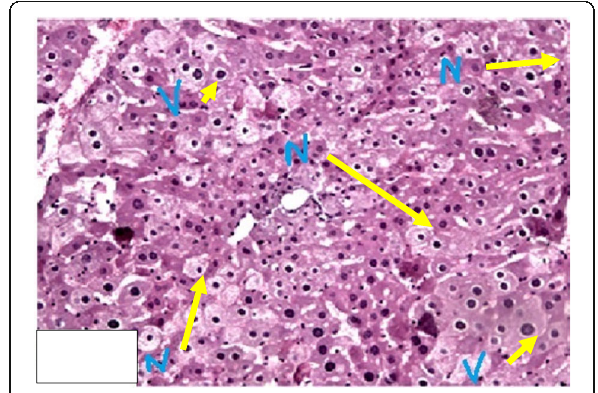
Fig. 3 Photomicrograph of liver section from a rat treated with four times the clinical dose of AS-AQ. (Magnification ×400). V = Hepatic vacuolation, N = Hepatic cell necrosis